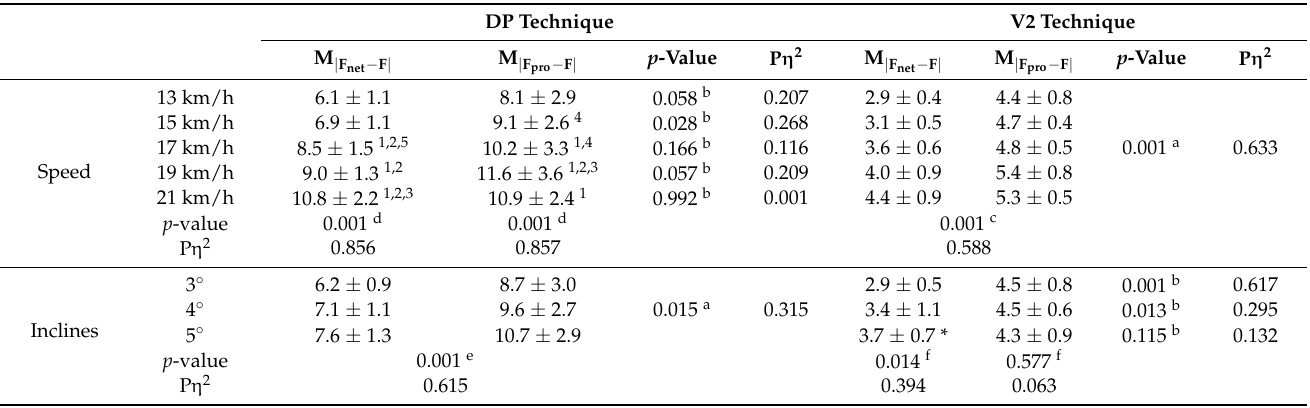
Table 2. Mean and standard deviation of the mean absolute difference for the DP technique ( n = 9) and V2 technique ( n = 10)